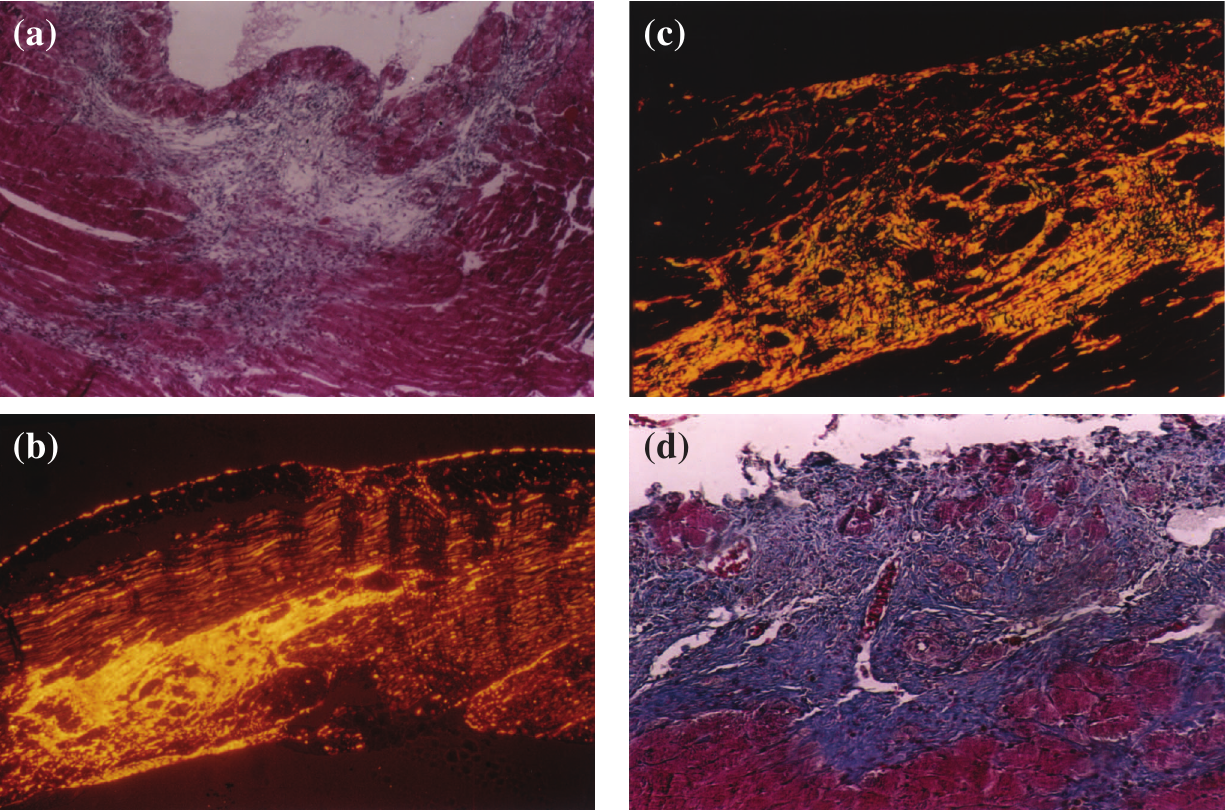
Figure 2 - (a) inflammatory infiltrate areas highly suggestive of a myocardial infarct in the subendocardial region of a hypertensive heart (magnification 100X); (b) postinfarct fibrotic areas in the right ventricular myocardium of a hypertensive animal, stained with picrosirius red using polarized light to show fibrillar collagen (in yellow, orange, or red) occupying a great proportion of collagen fibers (magnification 200X); (c) postinfarct fibrotic areas in the myocardium of a hypertensive animal, showing fibrillar collagen (in yellow, orange, or red) corresponding to a high proportion of collagen, with a small amount of reticular collagen (in green) (magnification 200X) (picro-sirius-red